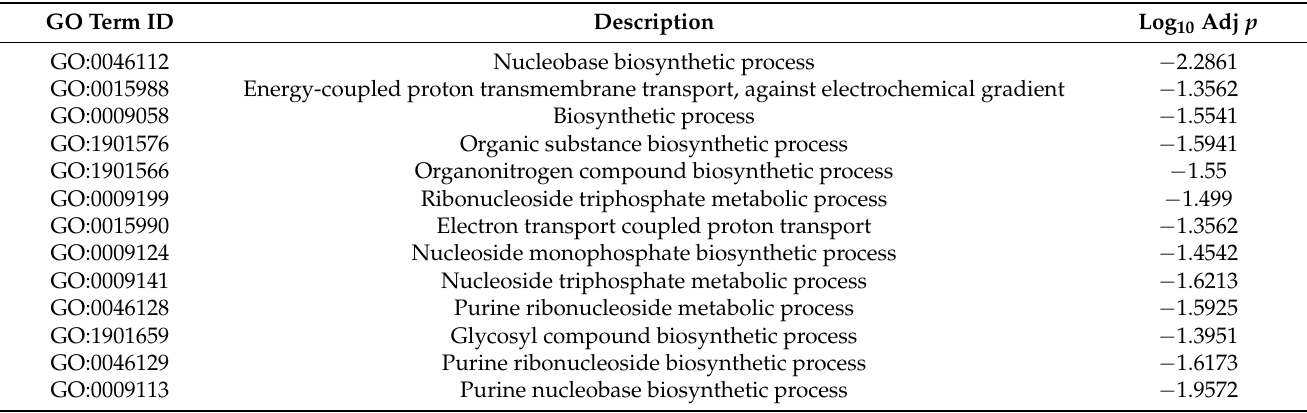
Figure 1. Visualization of the top terms in Gene Ontology (GO) biological processes obtained using over-representation analysis. The top GO terms were obtained using g:Profiler and clustered by ReVigo for visualization (adj p < 0.05). The data were plotted as log10 p -value against log size on a scatterplot. The GO terms were sized and colored according to the indicated scale. Table 1. A list of the top 13 gene ontology terms for biological processes that was obtained by over-representation analysis using g:Profiler (adj p < 0.05).